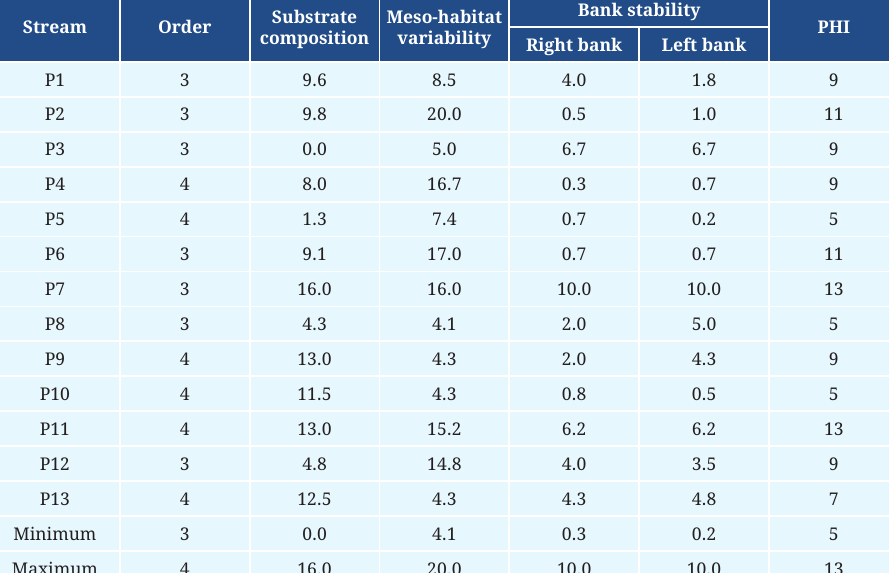
TABLE 2 | Habitat characteristics in each stream reach. Substrate composition = area covered by boulders, rocks, branches, trunks, and leaves. Meso-habitat variability = combination of water velocity and depth: slow and deep, fast and shallow, and slow and shallow (deep: > 0.5 m; fast: > 0.3 m/s). Bank stability = percentage of banks covered by rocks, vegetation and logs. PHI = physical habitat index. Stream order determined according to Strahler